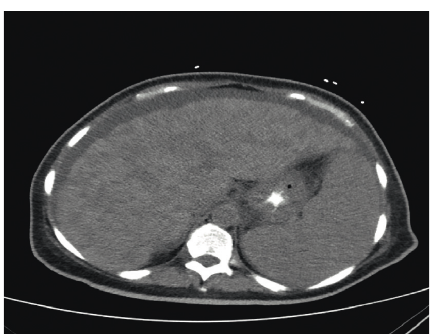
Figure 2: Computed tomography (CT) abdomen showing hep- atosplenomegaly, numerous hypodensities in the